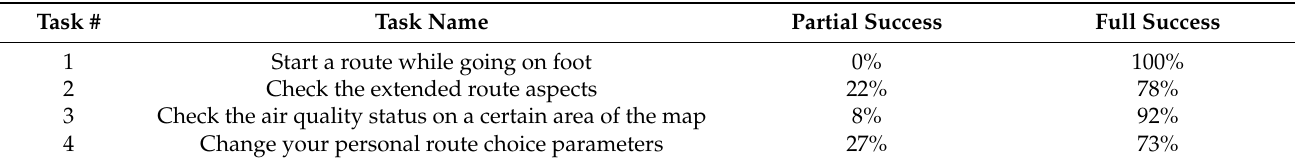
Table 6. Task completion results from the first two usability loops.